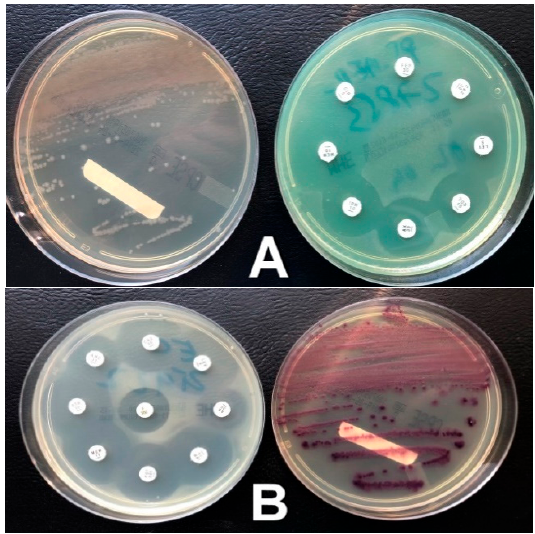
Figure 2. Petri dishes with E.Coli ( A ) and Klebsiella spp. strains ( B ).